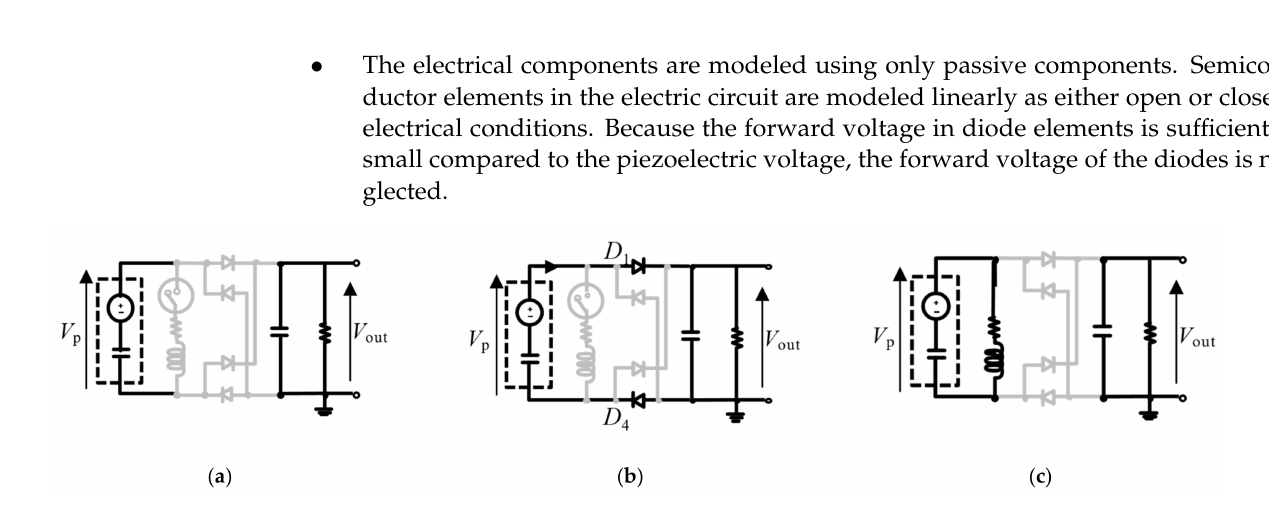
Figure 2. Circuit connections under each circuit equation. The black and gray lines show the conductive and nonconductive lines. ( a ) The piezoelectric charge is constant because of the nonconductive conditions of the switch and rectifier. ( b ) The piezoelectric charge outflows from clamped storage in the piezoelectric transducer to the smoothing capacitor owing to the conductive rectifier. This diagram indicates the condition in which the piezoelectric voltage sign is positive. ( c ) The piezoelectric charge vibrates through the inductor and capacitor. This connection is maintained for half of the LC resonance frequency